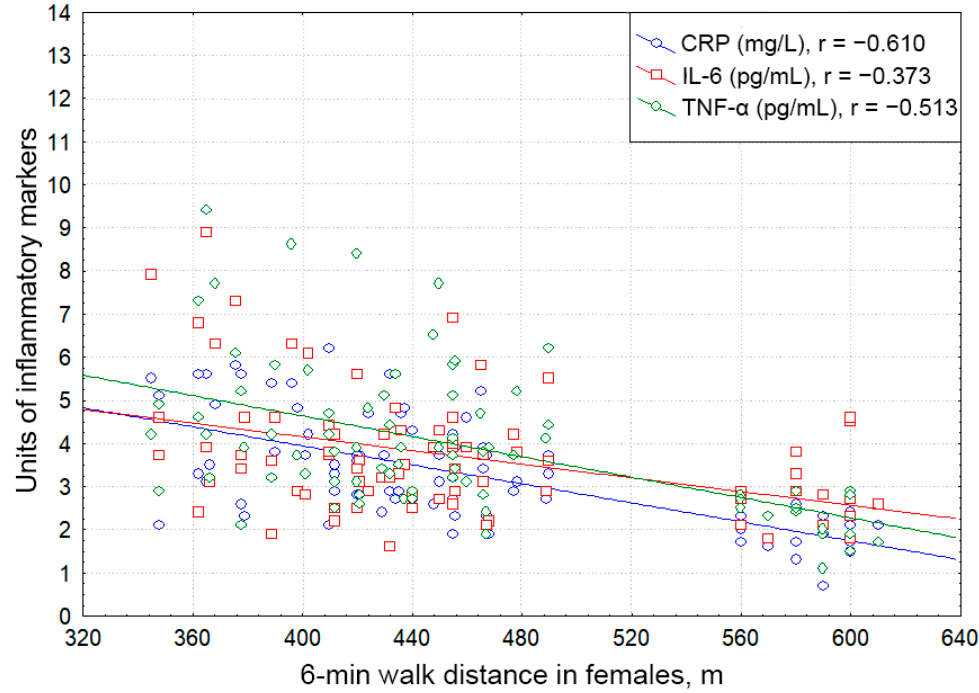
Figure 7. Correlative associations between C-reactive protein, interleukin-6, and tumor necrosis factor alpha serum levels and 6 min walk test results in females with hypertension complicated by CHF with preserved ejection fraction. Each dot represents a participant. Abbreviations: CRP: C-reactive protein, TNF- α : tumor necrosis factor alpha, IL-6: interleukin-6. The level of CRP in healthy males was significantly inferior to that in HNT males without LVDD ( p = 0.03), with LVDD grade 1 ( p = 0.01), with HNT and LVDD grade 2 ( p = 0.001). The level of CRP in healthy females was significantly inferior to that in HNT females without LVDD ( p = 0.05), with LVDD grade 1 ( p = 0.05), with LVDD grade 2 ( p = 0.01). In healthy men and women, as well as in hypertensive men and women without LVDD, the level of CRP did not differ significantly ( p = 0.21 and p = 0.45, respectively). The level of TNF- α in healthy males was the lowest, significantly inferior to that in HNT males without LVDD ( p = 0.05), with LVDD grade 1 ( p = 0.01), and with HNT and LVDD grade 2 ( p = 0.001). The level of TNF- α in healthy females was significantly inferior to that in HNT females without LVDD ( p = 0.05), with LVDD grade 1 ( p = 0.03), and with LVDD grade 2 ( p = 0.001). In healthy men and women, as well as in hypertensive men and women without LVDD, the level of TNF- α did not differ significantly ( p = 0.11 and p = 0.09, respectively). The level of IL-6 in healthy males was inferior to that in HNT males without LVDD ( p = 0.10), with LVDD grade 1 ( p = 0.05), and with HNT and LVDD grade 2 ( p = 0.001). The level of CRP in healthy females was inferior to that in HNT females without LVDD ( p = 0.12), with LVDD grade 1 ( p = 0.07), and with LVDD grade 2 ( p = 0.01). In healthy males and females, as well as in hypertensive males and females without LVDD, the level of CRP did not differ significantly ( p = 0.88 and p = 0.75, respectively).